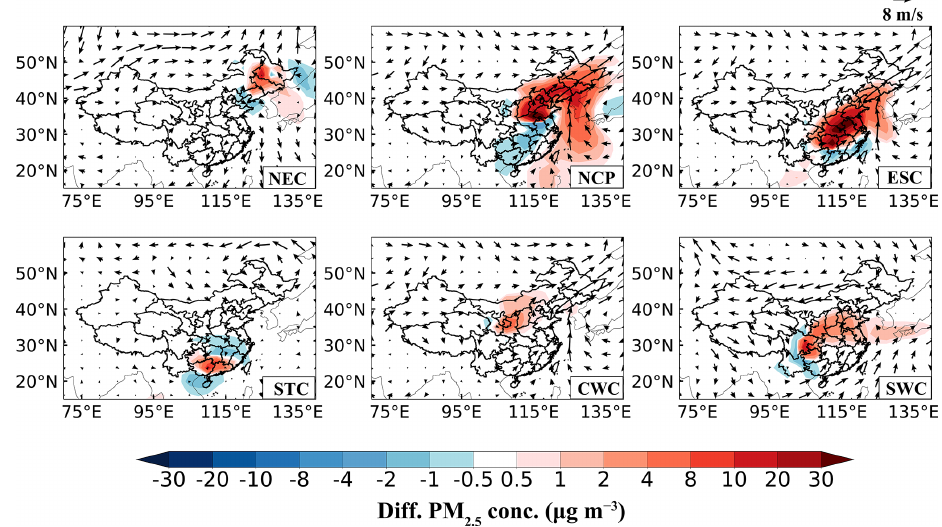
Figure 7. Composite differences in winds at 850hPa (ms − 1 ) and near-surface PM 2 . 5 concentrations (µm − 3 ) between the most polluted and normal days in February 2020. The most polluted day is defined as the day with the highest daily PM 2 . 5 concentration in February 2020 in each receptor region in China.